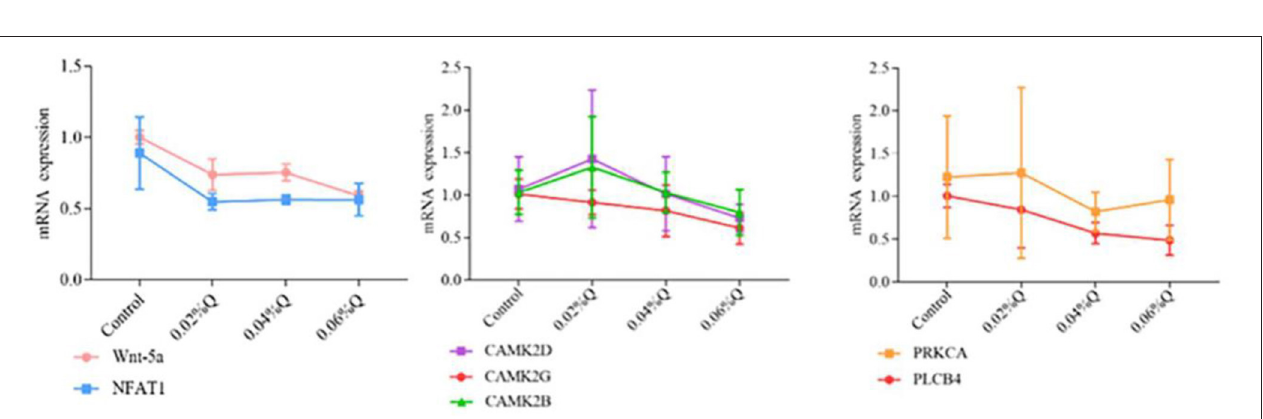
FIGURE 4 | Correlations of mRNA expression level of seven random DEGs between the level of calcium and phosphorus using RNA-seq and RT-qPCR. The X-axis represents the seven selected genes for RT-qPCR assays and the Y-axis represents the log (fold change) 2 derived from RNA-seq. Values are mean ± SEM ( n = 6). 0.02, 0.04, and 0.06%Q represent 0.02% quercetin, 0.04% quercetin, and 0.06% quercetin, respectively.